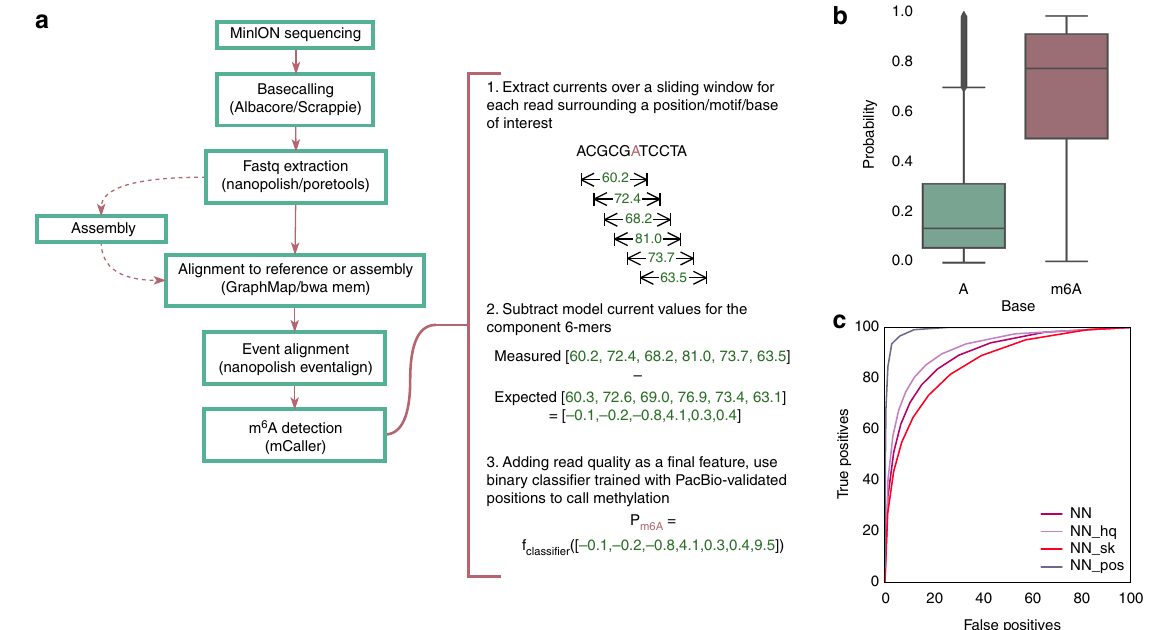
Fig. 2 mCaller work fl ow and classi fi cation of E. coli sites in R9.4 data. a The pipeline for classi fi cation of adenines as methylated or unmethylated. b Probabilities of methylation de fi ned by a neural network classi fi er for methylated compared to unmethylated positions in E. coli , with a model trained on one dataset and tested on a second. c ROC curves for the neural network model using R9.4 data, showing true positive rate (methylated positions correctly identi fi ed) as a function of false positive rate (unmethylated positions called as methylated) with varying probability thresholds for classi fi cation. We tested modi fi cations to the standard model ( “ NN ” ) using only high quality reads (average base quality> 9, “ NN_hq ” ) and classifying observations that included a maximum of two skips ( “ NN_sk ” ). A curve was calculated for genomic positions with ≥ 15× coverage by varying the fraction of reads with probability of methylation scores ≥ 0.5 required to de fi ne a position as methylated ( “ NN_pos ” ). Boxplot center lines show medians and whiskers 1.5x interquartile